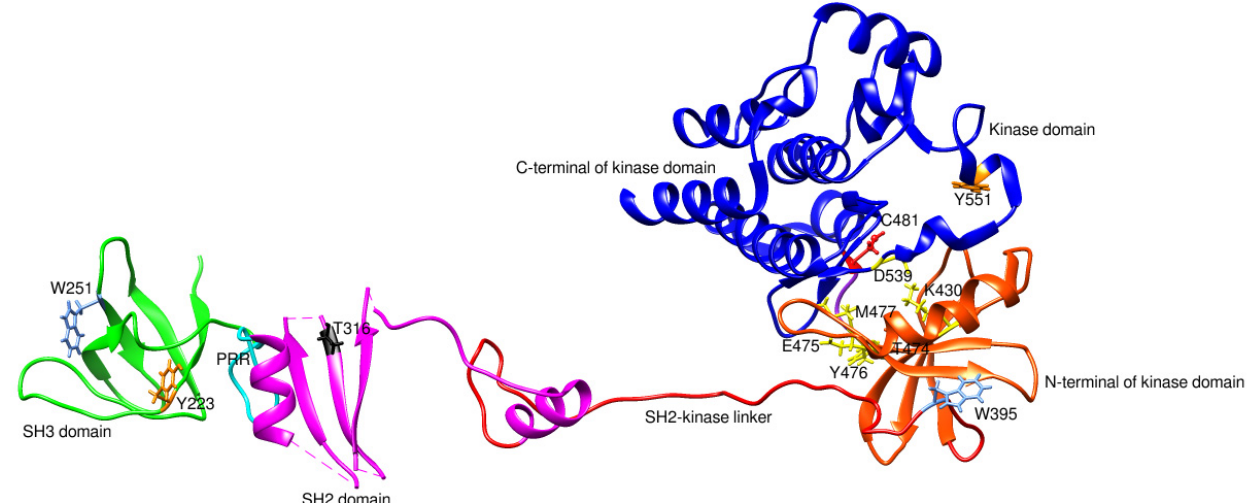
Figure 2. 3D structure of the whole BTK (4XI2). PRR is the proline-rich region. Y551 and Y223 are phosphorylation sites. C481 is a covalent inhibitor binding site and the primary site of mutation leading to drug resistance. T316 and T474 are mutation sites conferring drug resistance. K430, E475, Y476, M477, and D539 are residues of the non-covalent inhibitor binding site. W395 and W251 undergo conformational changes in response to conformational changes in the kinase and SH3 domain, respectively.